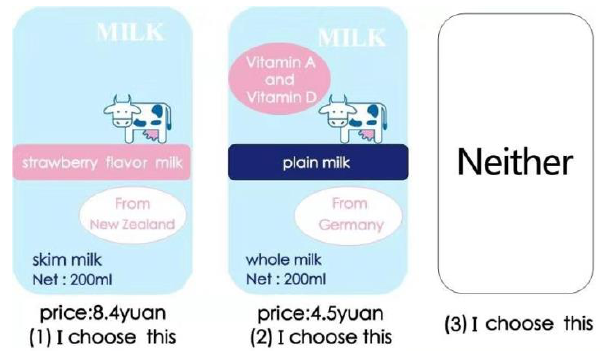
Figure 1. Sample choice task card.